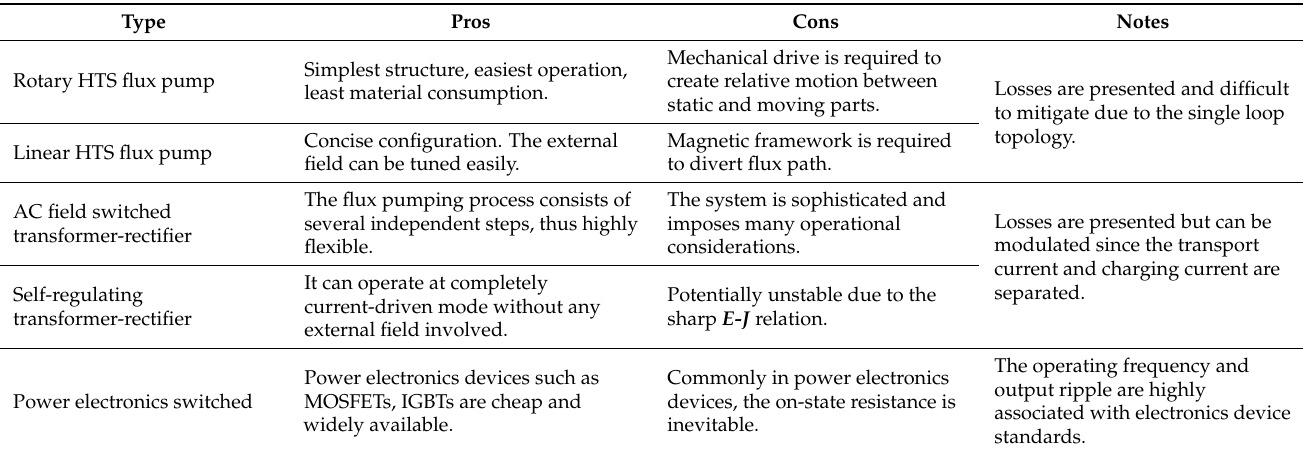
Table 1. Comparison between major HTS flux pump